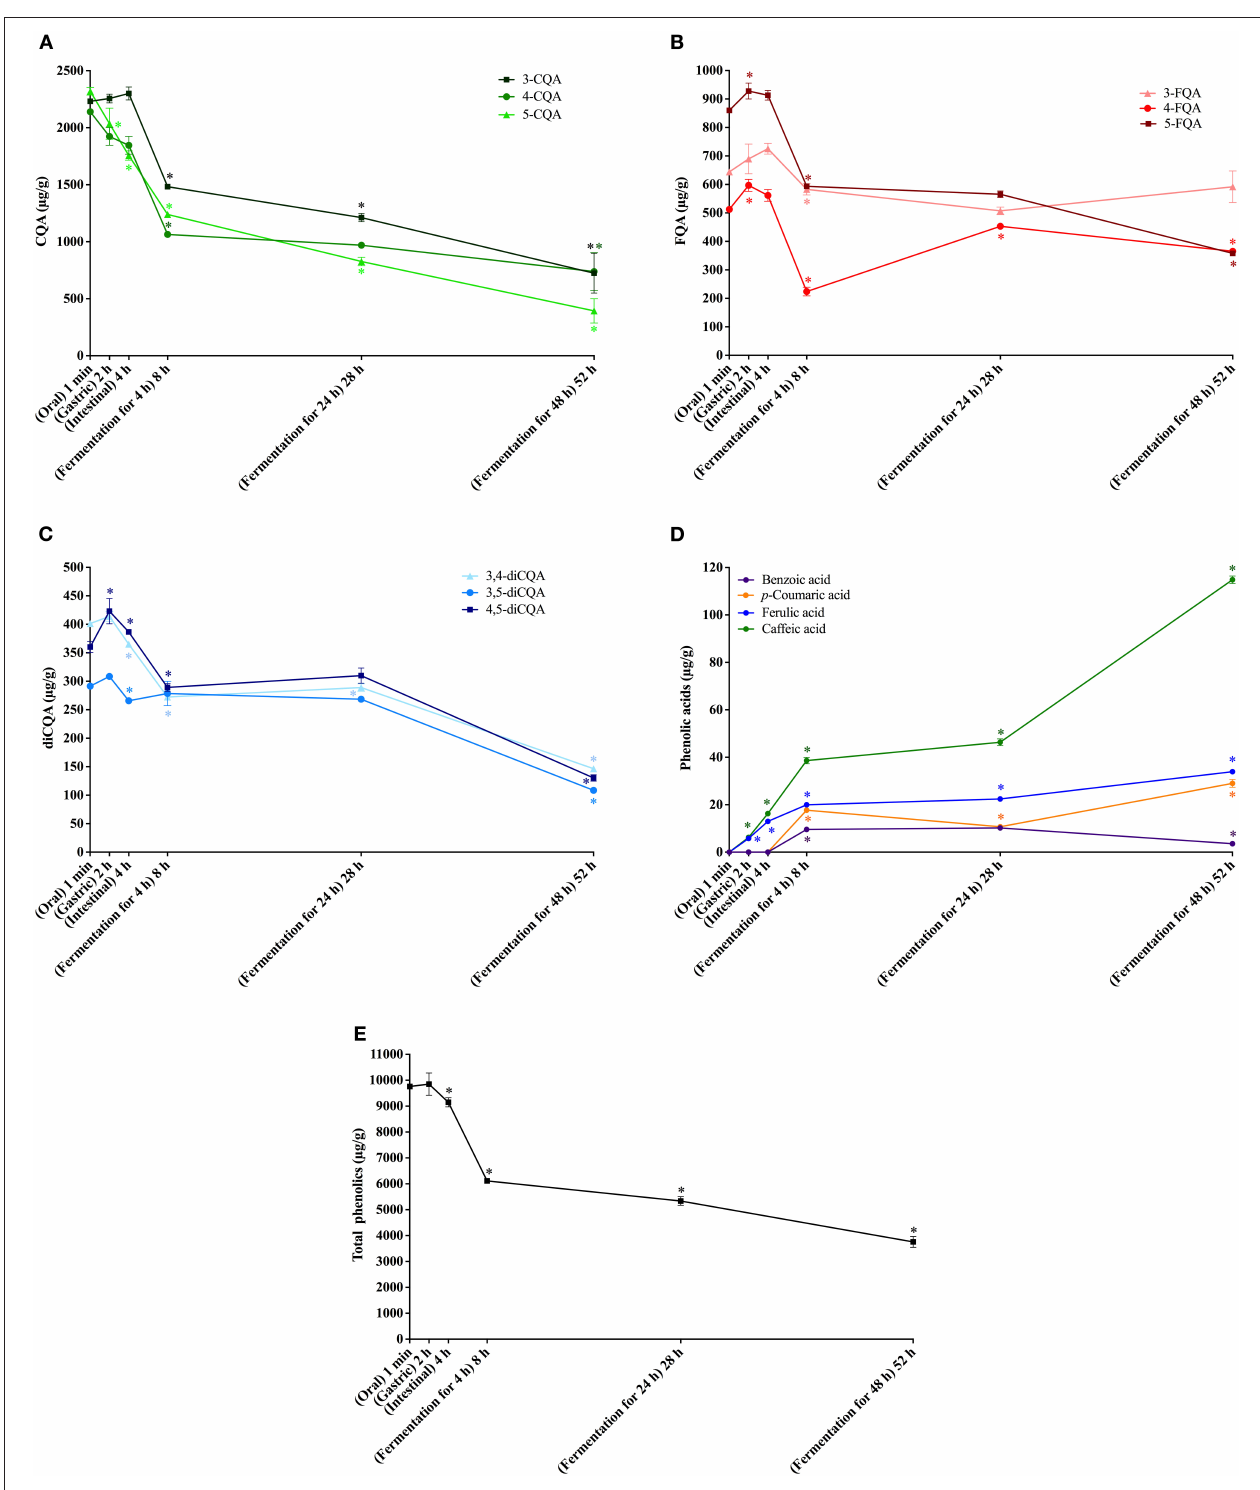
FIGURE 1 | In vitro simulated digestion (oral, gastric and intestinal steps) and gut fermentation of coffee free phenolic compounds: caffeoylquinic acids (CQA, A ), feruloylquinic acids (FQA, B ), dicaffeoylquinic acids (diCQA, C ), phenolic acids (D) and total phenolics (E) . The asterisk indicates a significant difference in relation to the previous step (ANOVA followed by Tukey’s post-test, p < 0.05).